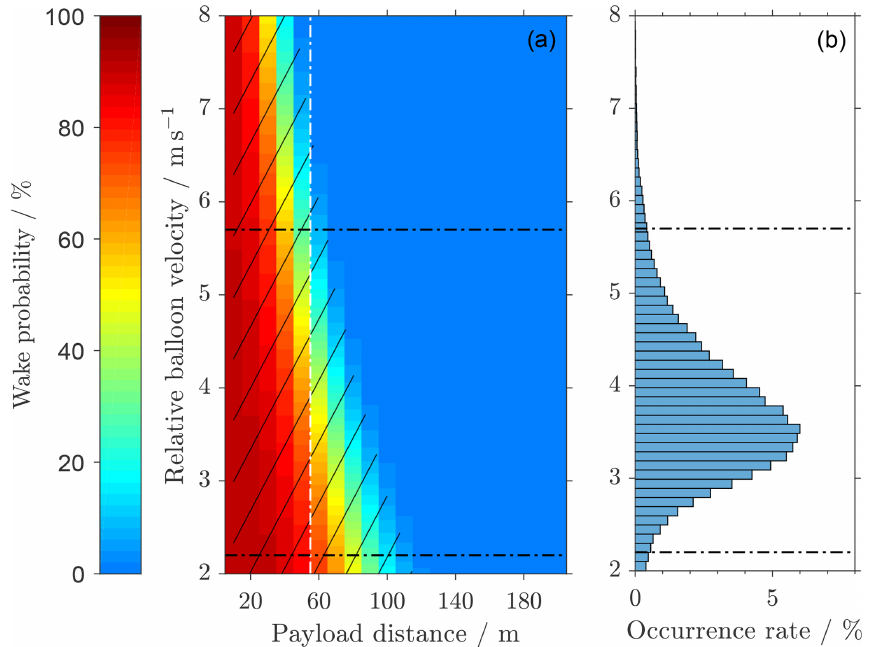
Figure 8. Same as Fig. 6, but showing the influence of the relative vertical balloon velocity w rel on the payload–wake distance (wind shear: 10ms − 1 km − 1 , no wind